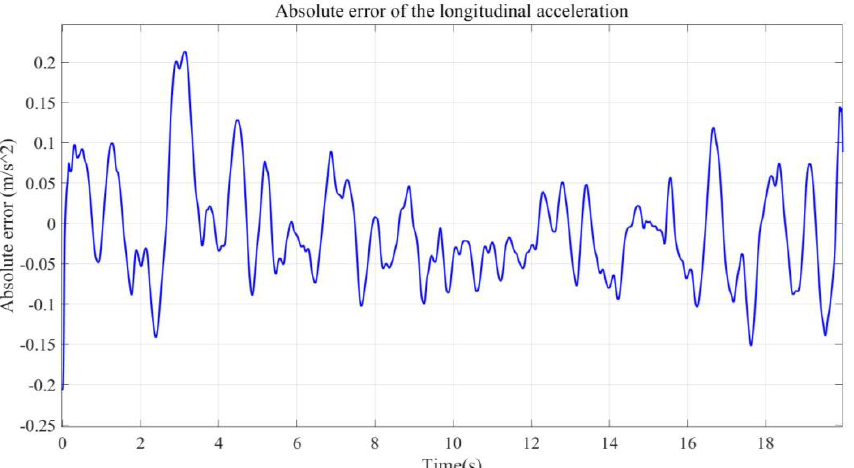
Figure 18. Absolute error of the longitudinal acceleration between the vehicle dynamics model using estimation results and the real vehicle test.